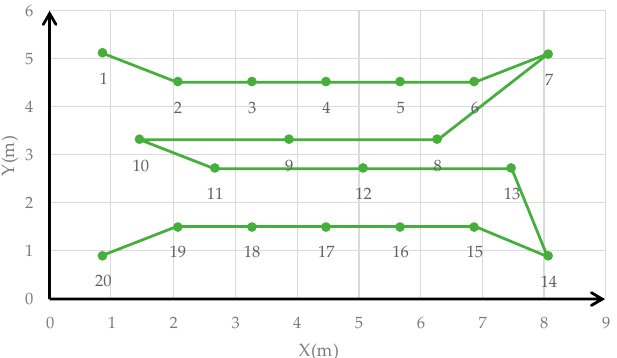
Figure 11. Distribution of 20 positioning points.